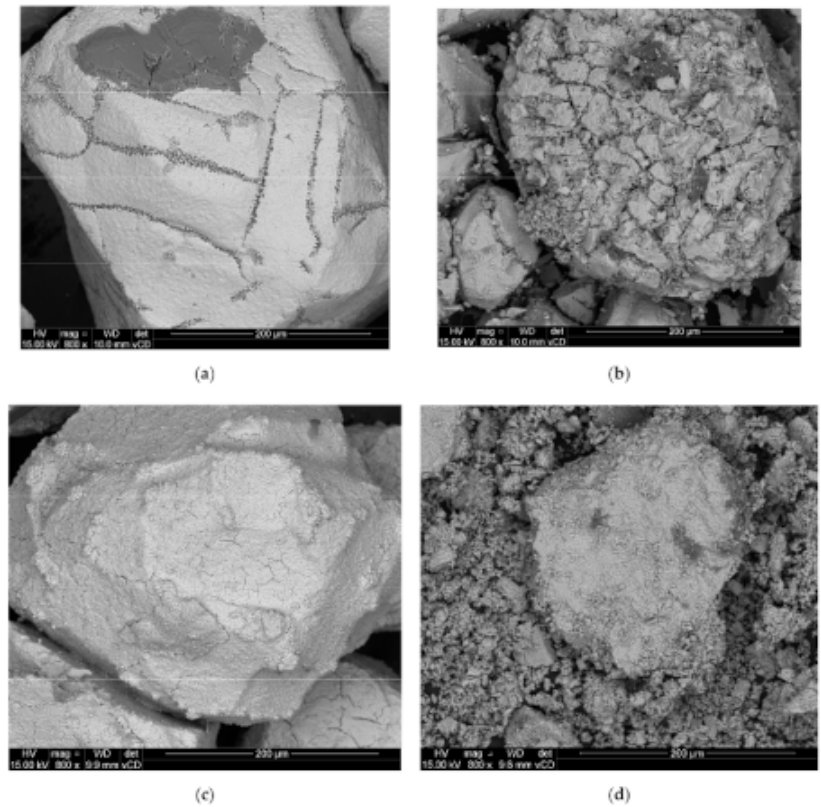
Figure 13. Backscattered SEM images of reduced chromite particles before ( a ) and after ( b ) leaching, and pre-oxidized/reduced chromite particles before ( c ) and after ( d )